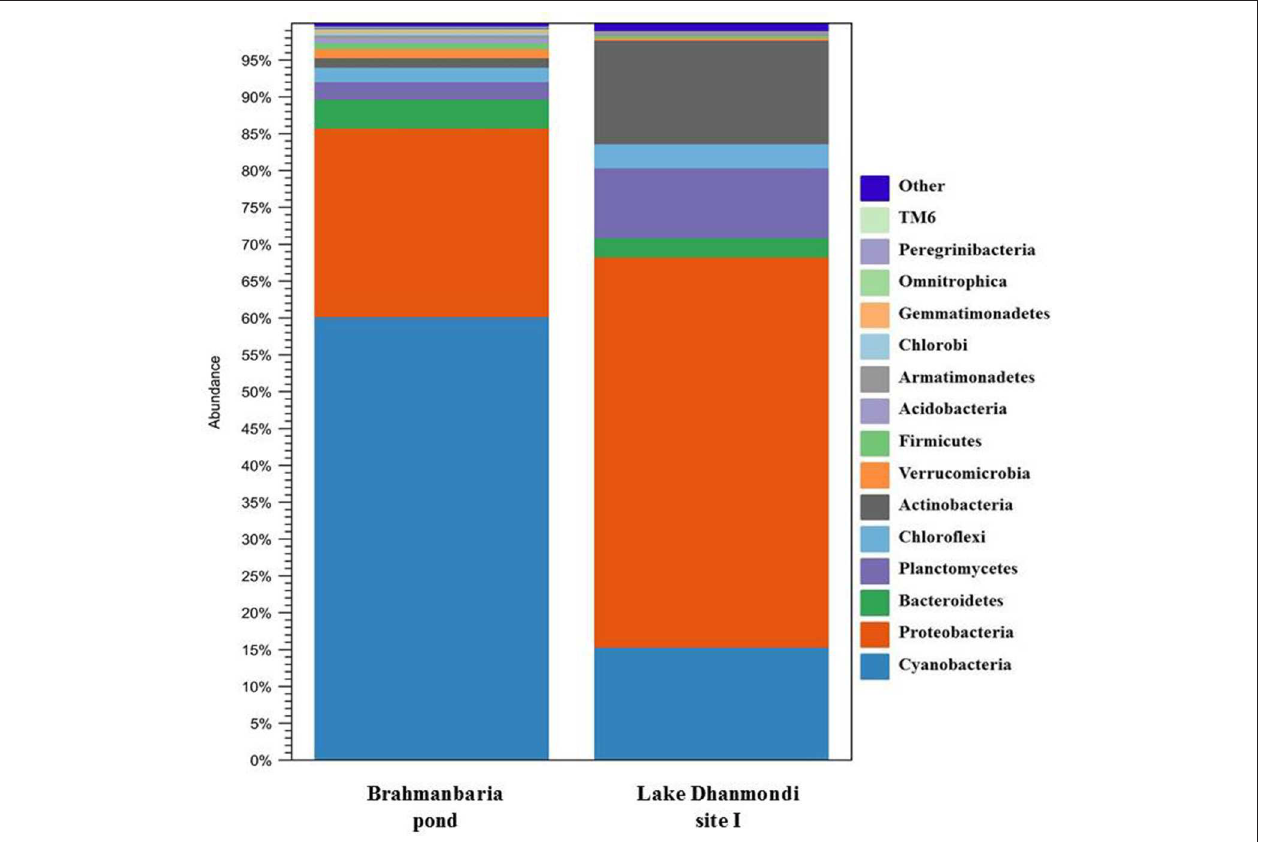
FIGURE 6 | Diversity of bacterial phyla in Brahmanbaria pond and Lake Dhanmondi site I in November 2008 and July 2008, respectively based on Deep 16S rDNA sequencing.